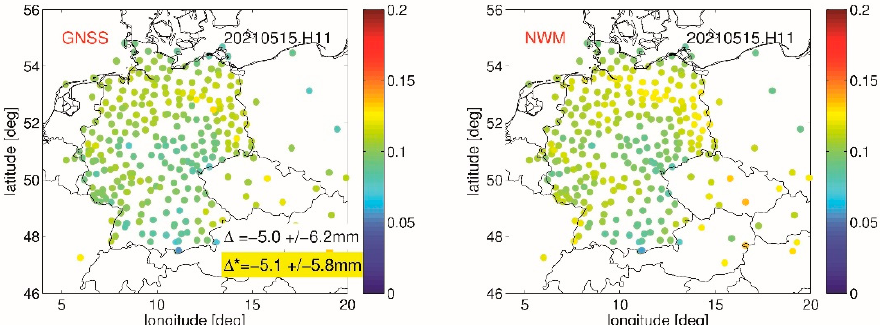
Figure 8. A one-to-one comparison of GNSS and NWM ZWDs in meters on the 15 May 2021 at 11 UTC. Left panel: the ZWDs are estimated with the GNSS. Right panel: the ZWDs are derived from the NWM. For the considered epoch about 300 stations provide ZTDs. The numbers in the left panel correspond to the mean and standard deviation between the GNSS and NWM ZTDs. The numbers with the yellow background correspond to the case when we corrected the GNSS ZTDs a posteriori. For details, refer to the